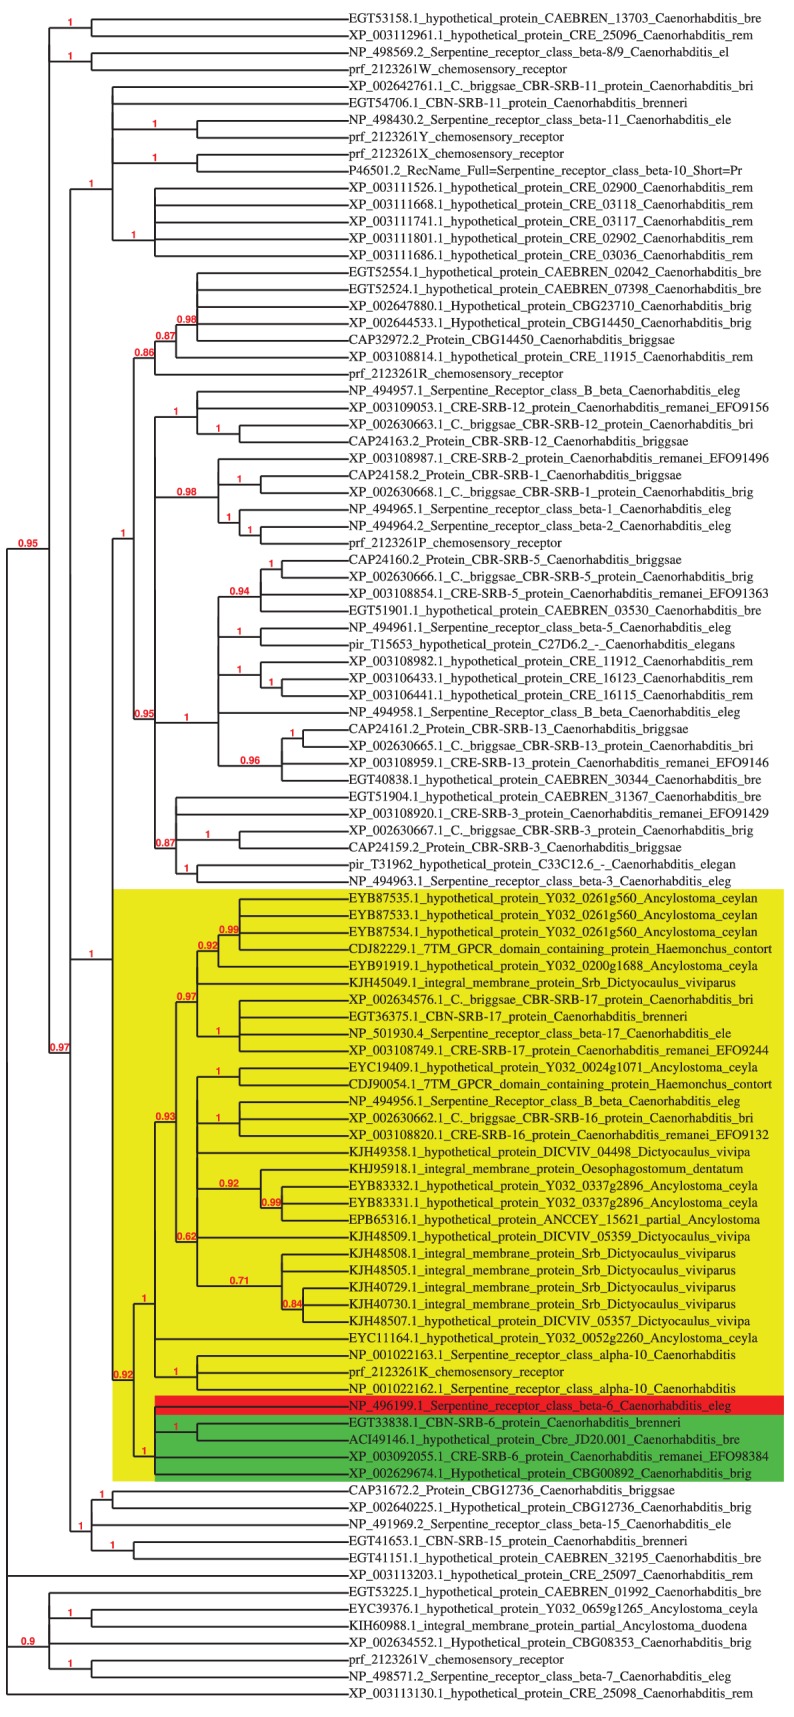
C. elegans srb-6 has homologs within the Caenhorabditis genus and the nematode phylum.srb-6 is highlighted in red. Note that srb-6’s closest homologs (highlighted in dark green) are within the Caenhorabditis genus, and a larger monophyletic group contains nematode species outside the Caenhorabditis genus (highlighted in light green). The dataset includes 100 protein sequences retrieved by BLAST with E-value <0.0001.